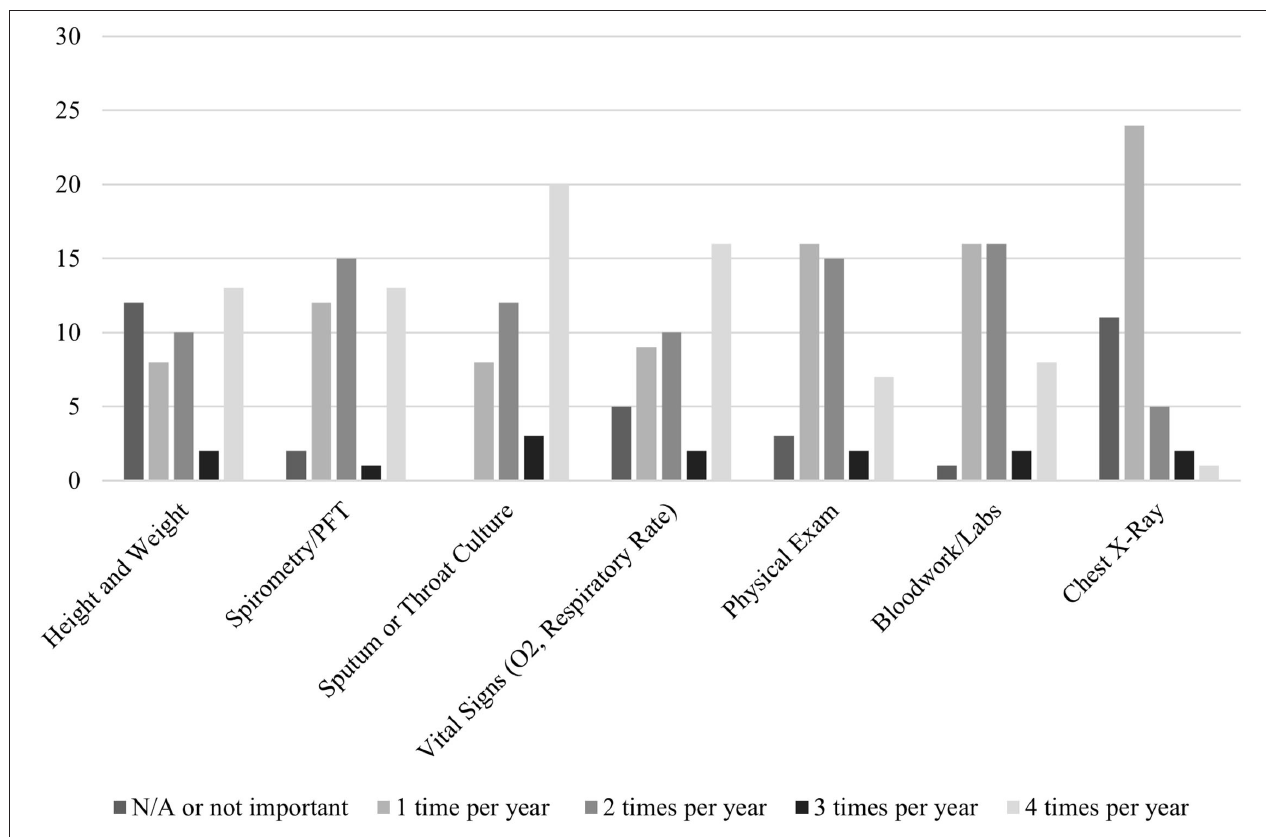
FIGURE 2 | Frequency of obtaining clinical data as desired by families.